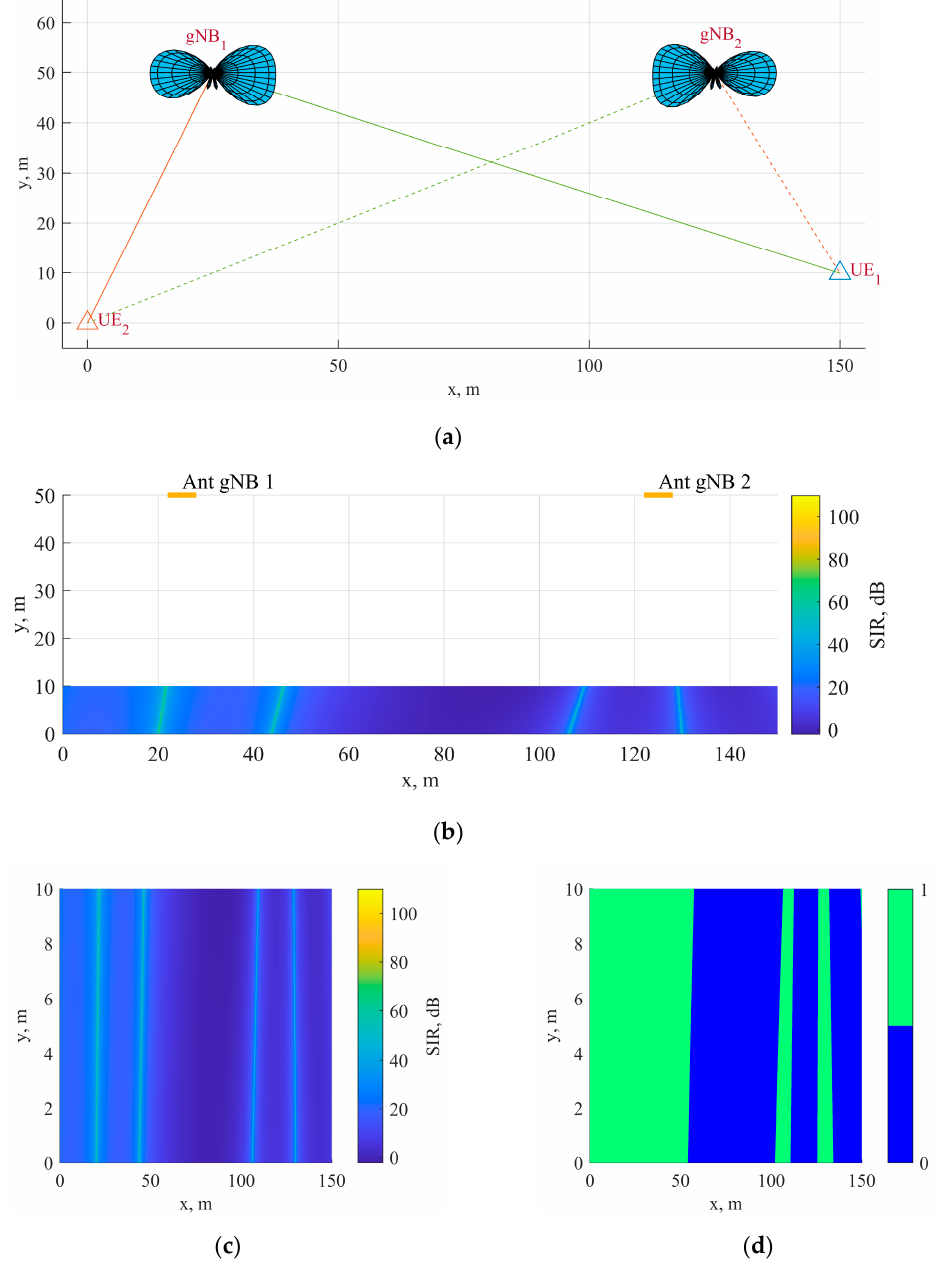
Figure 1. Simulation scenario 1: ( a ) gNB with AA pattern and UE trajectories on the x-y plane; ( b ) Map of UE SIR values with gNB location on the x-y plane; ( c ) Map of SIR values along UE trajectories; ( d ) Map of SIR values exceeding a given threshold along UE